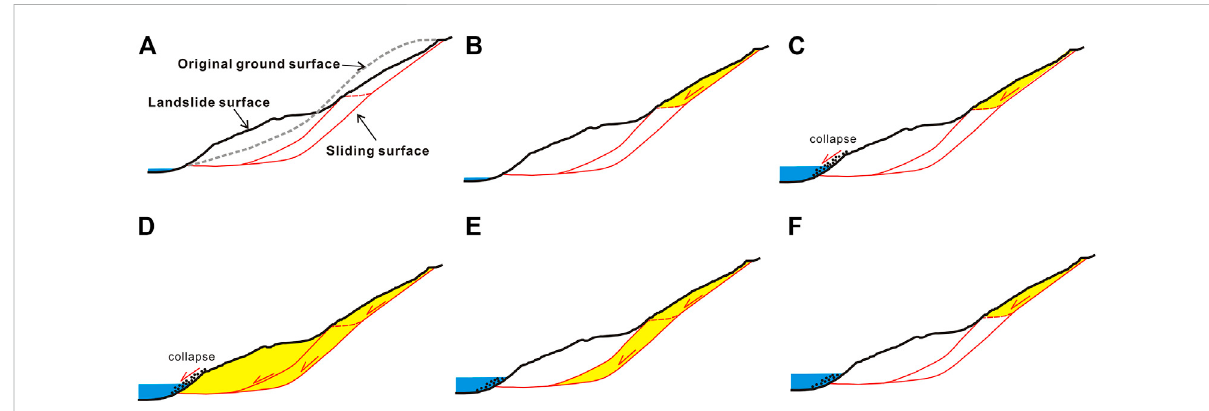
FIGURE 11 Schematic diagram of long-time failure processes of NLJL before and after impoundment. (A) Landforms before and after landslide sliding; (B) Landslide deformation part before reservoir impoundment; (C) Front edge collapse after reservoir impoundment; (D) After the collapse, the front edge traction caused overall deformation; (E) The stress of the leading edge gradually balanced and the deformation in the front and middle parts stopped; (F) As of 2022, the deformation mode reverted to that of upper deformation